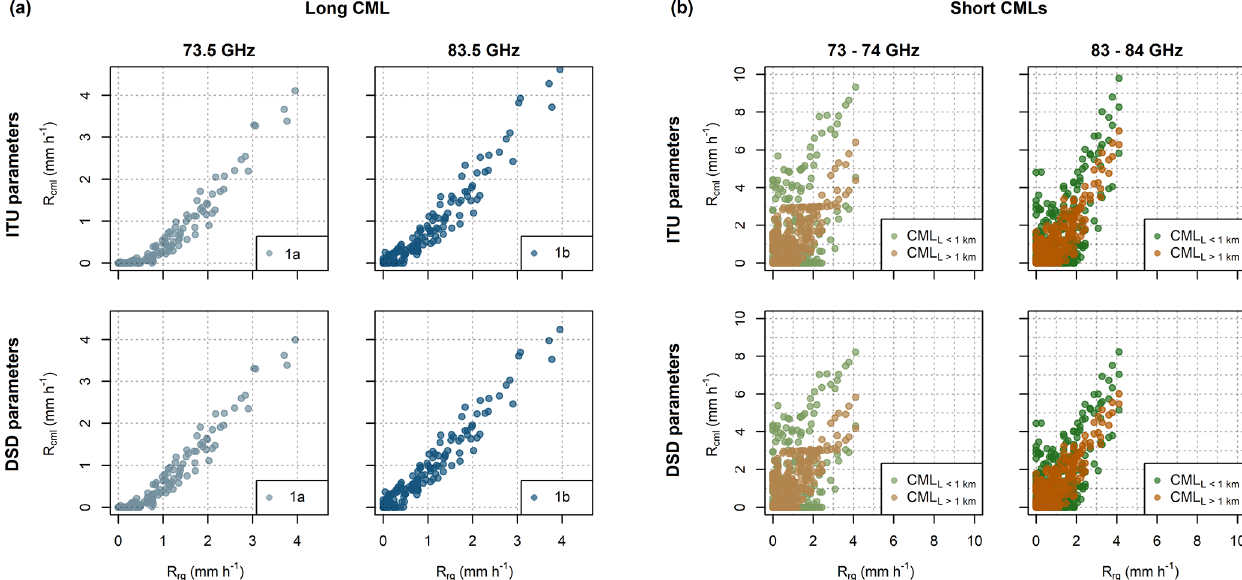
Figure 9. CML QPEs for the long CML (a) and short CMLs (b) when using the k – R model with ITU (top) and DSD-derived (bottom) parameters. Results are shown for both frequency ranges. QPEs for short CMLs are differentiated by color into two groups to depict CMLs with path lengths shorter and longer than 1km